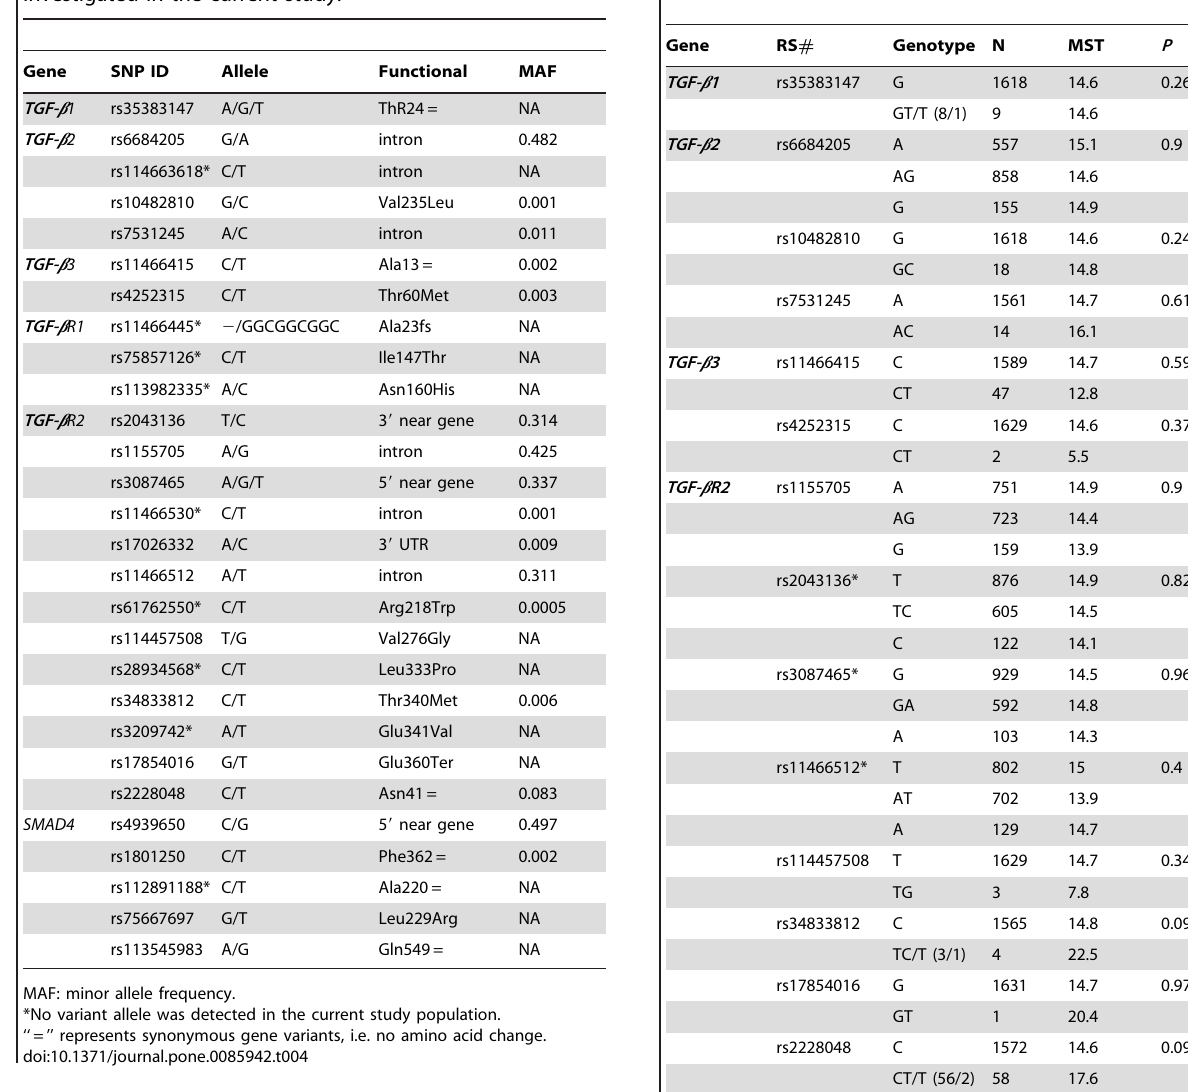
28 tested SNPs is described in Table 4. No variant allele was detected for nine SNPs. Among the six common SNPs with minor allele frequency greater than 5%, three followed the Hardy Weinberg Equilibrium (HWE) and three deviated from the HWE (Table 2). The genotype distribution and overall survival time by genotype of the 19 informative SNPs are presented in Table 5. A significant association of SMAD4 SNP rs113545983 with OS was observed (Panel A, Fig. 3), and the association was stronger in patients with advanced disease (Panels C and D, Fig. 3) than those with localized disease (Panel B, Fig. 3). The mutant G allele of SNP rs113545983 remained as a significant predictor for death in Cox regression model after adjusting for stage and resection status among all patients (HR: 1.54, 95% CI: 1.21–1.96, P , 0.001). No other SNPs showed significant association with OS. TGF- b R2 SNP rs2248048 had a weak association with OS without statistical significance ( P =0.09, log rank test).